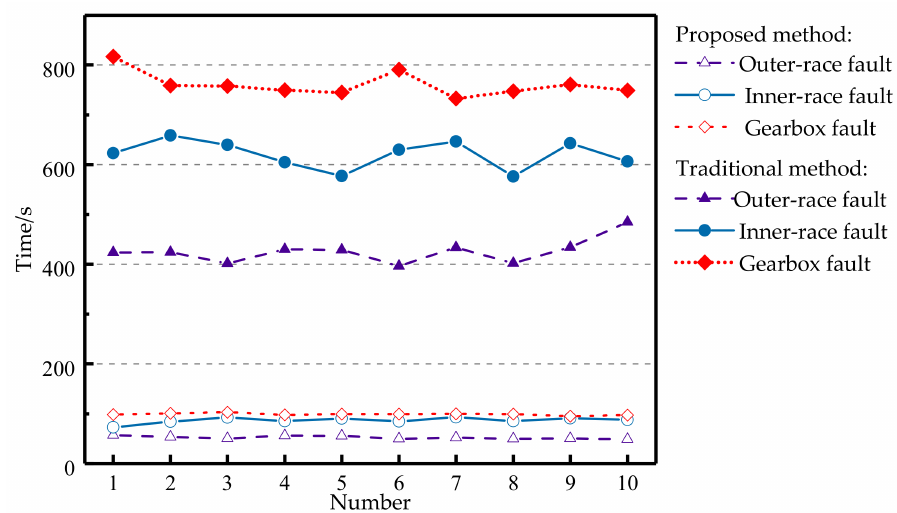
Figure 15. Detection time using two